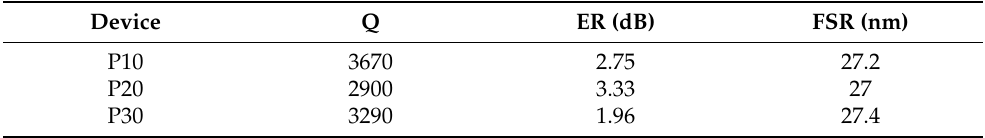
Table 1. Spectral characteristics of the static ring